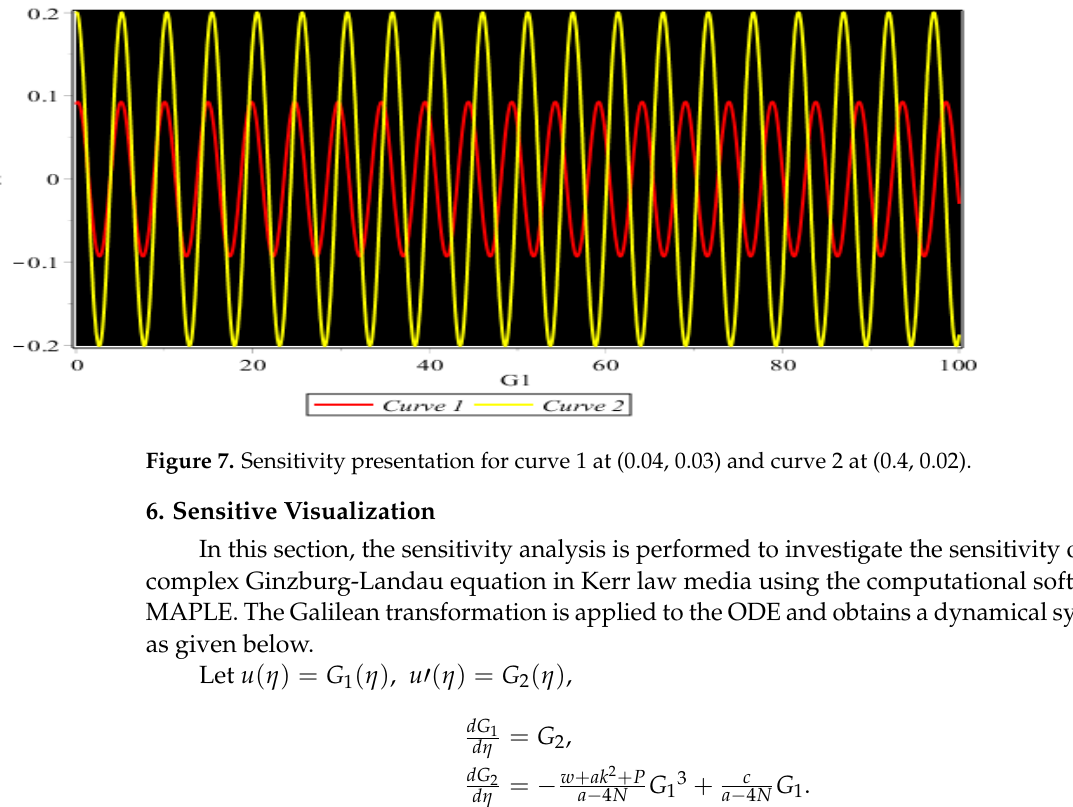
Figure 6. Sensitivity presentation for curve 1 at (0.09, 0.03) and curve 2 at (0.2, 0.02).